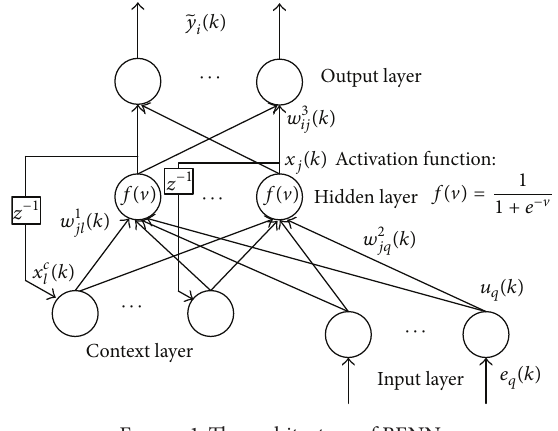
Figure 1: The architecture of BENN.